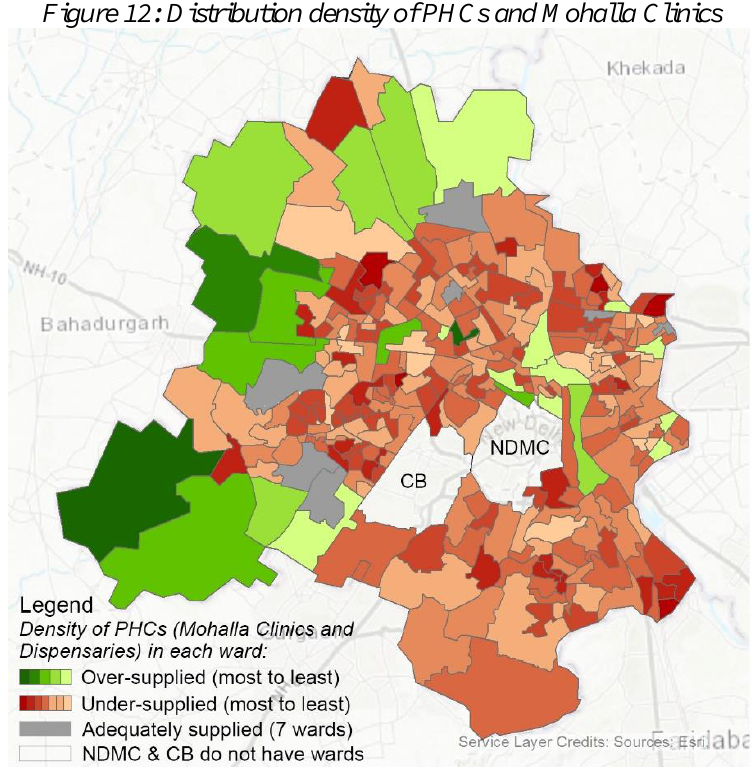
Figure 12: Distribution density of PHCs and Mohalla